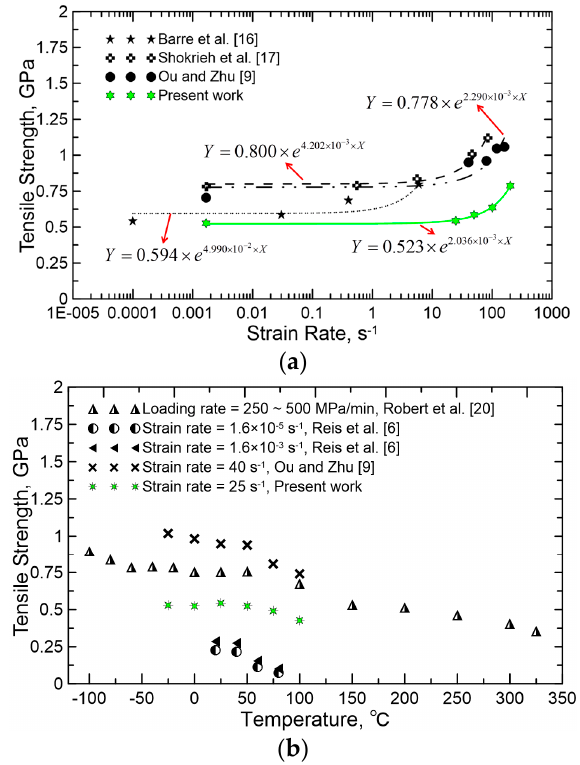
Figure 13. Comparison of the tensile strength of GFRP specimens at different ( a ) strain rates and ( b ) temperatures with literatures.